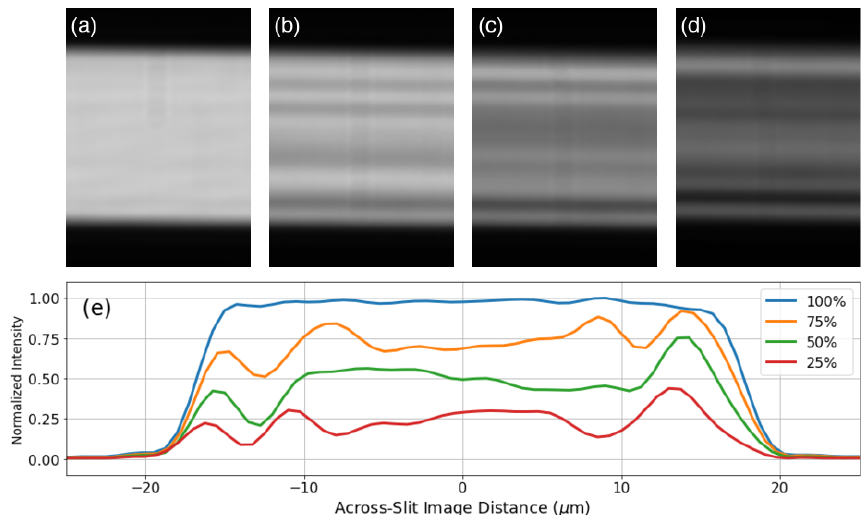
Figure 8. (a, b, c, d) Typical raw images recorded on the image sensor as the knife edge obscures more and more of the incoming beam (only regions of interest shown): (a) fully illuminated (100%) (b) 75% unobstructed, (c) 50% unobstructed, and (d) 25% unobstructed. (e) One-dimensional profiles obtained by averaging the panels in the top row along vertical cross sections in the top image, which would correspond to variations across the shorter dimension of the slit. Note the decreasing intensity as the knife edge obscures more of the light, apparent in the change in brightness of the figures from left to right. Note also that the slit homogenizer effectively reduces the sharp gradient that would be present along a knife edge with a typical slit and spreads the light fairly uniformly across the